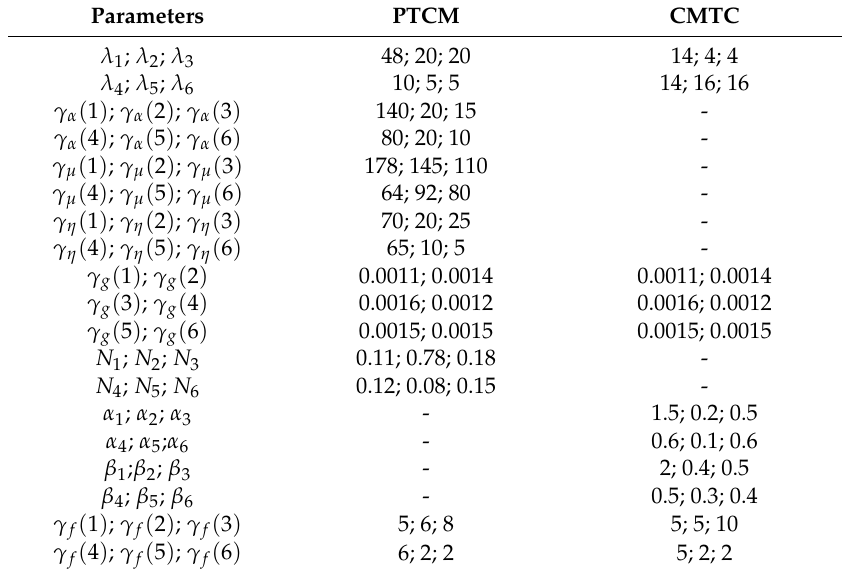
Table 2. Constant parameters of both proposed control approaches.